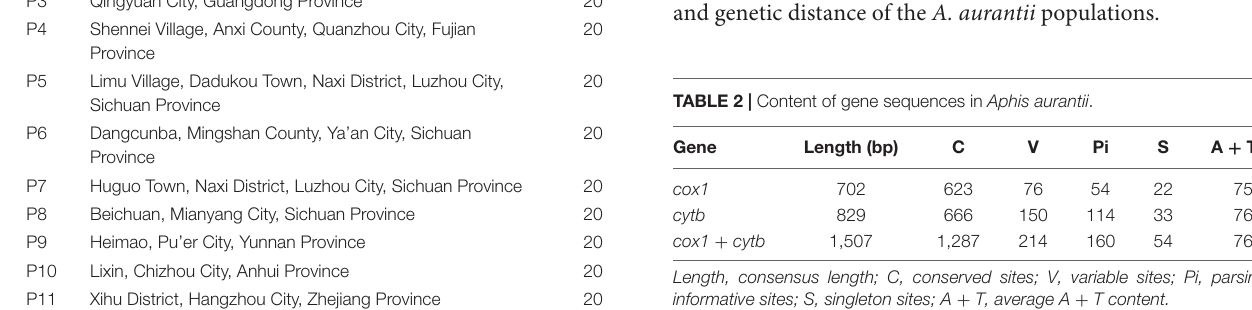
number of polymorphic sites ( S ) ranged from 37 (P7) to 88 (P11). The H d was 1.000 for all populations. The Pi values varied from 0.0112 ( ± 0.0008, P2) to 0.0211 ( ± 0.0014, P9). The AMOVA showed more variation of genetic differentiation within populations than among populations of A. aurantii ( Table 4 ). Over 87.49% variation of genetic differentiation occurred within populations, and only 12.51% of the genetic variation was found among populations. The pairwise F st values were highly variable, ranging from 0.0229 (between populations P3 and P4) to 0.2984 (between populations P2 and P11). High genetic differentiations were present between populations P2 and P11 ( F st > 0.25, p < 0.05), whereas no significant differentiations were present between other pairwise populations ( Table 5 ). Most of the N m values from the gene flow analysis were more than 1, except for the negative values between P11 and populations P2, P3, P4, P7, and P8 ( Table 5 ). The highest N m value was found between P3 and P4. The IBD analysis revealed a highly significant positive correlation ( r = 0.4190, p < 0.01) between the geographic distance and genetic distance of the A. aurantii populations.